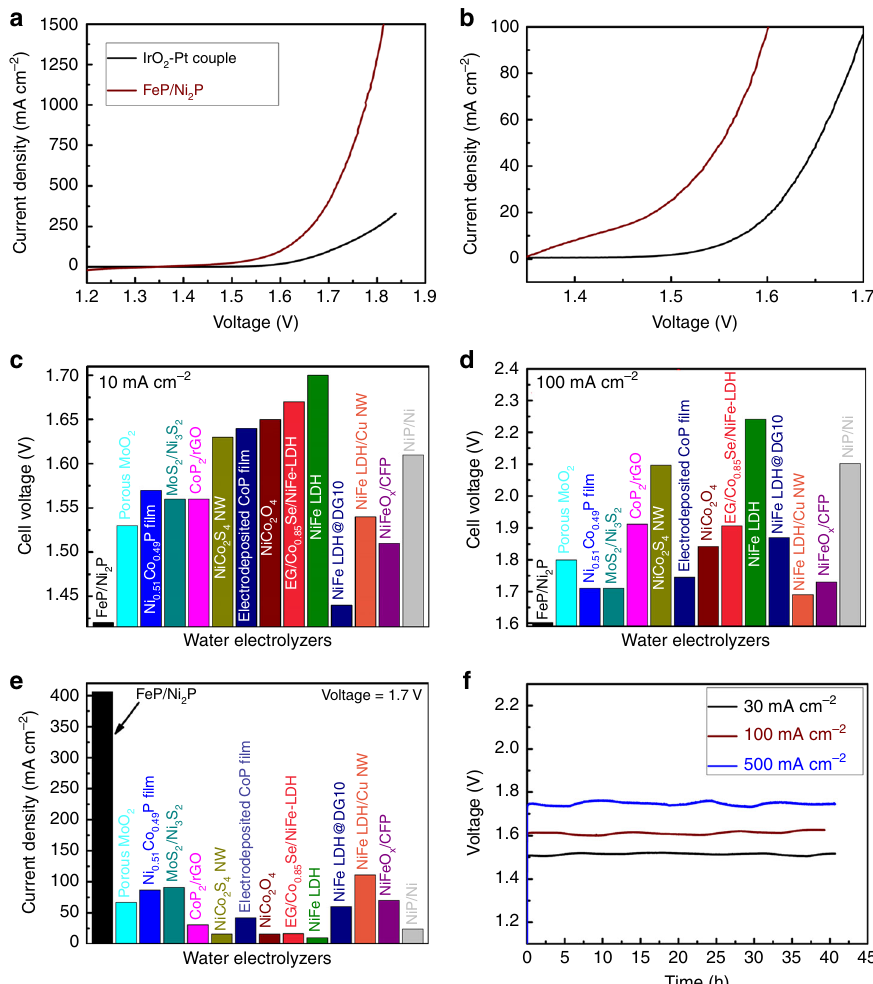
Fig. 4 Overall-water-splitting activity of the FeP/Ni 2 P catalyst. a The polarization curve of FeP/Ni 2 P and IrO 2 -Pt coupled catalysts in a two-electrode con fi guration. b Enlarged version at low current density region of a . c Comparison of the cell voltages to achieve 10 mA cm − 2 among different water alkaline electrolyzers. d Comparison of the cell voltages to achieve 100 mA cm − 2 among different water alkaline electrolyzers. e Comparison of the current densities at 1.7 V for this FeP/Ni 2 P catalyst with available non-noble bifunctional catalysts. f Catalytic stability of the FeP/Ni 2 P catalysts at 30, 100, and 500 mA cm − 2 for around 40 h. Electrolyte: 1 M